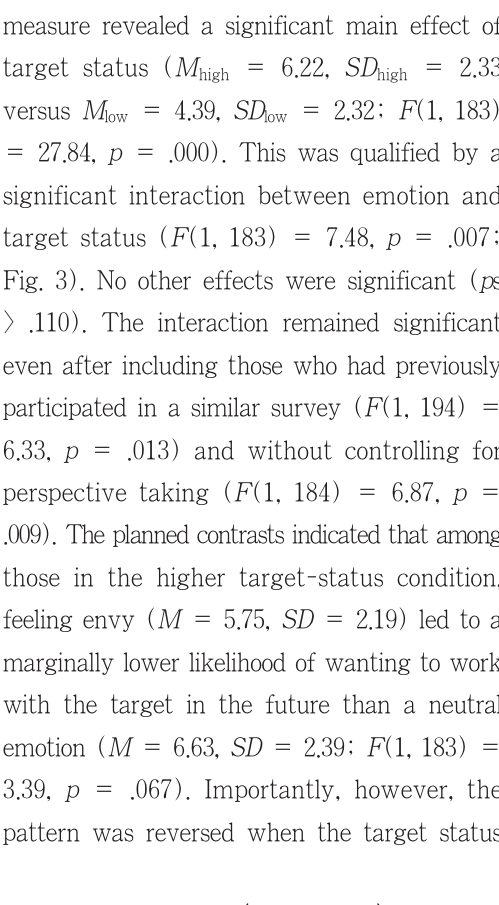
<Figure 3> Likelihood of wanting to work with the target in the future (experiment 3). The error bars are based on the 95% confidence